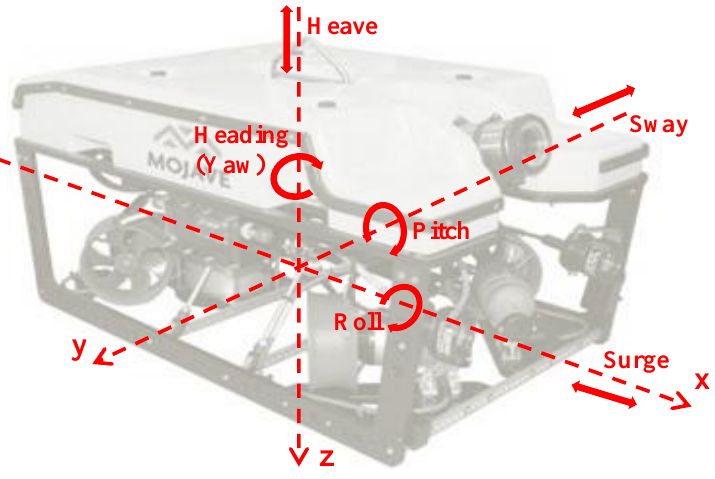
Figure 3. ROV with six degrees of freedom [127].